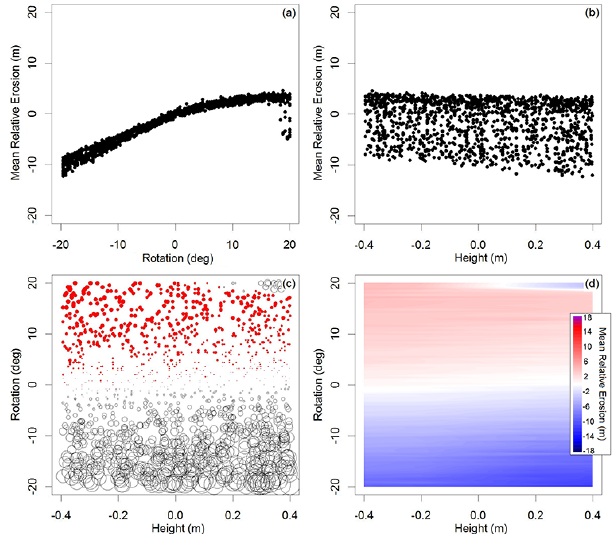
Figure 6. Wave rotation (a) and wave height (b) components of wave climate plotted against spatially averaged mean relative ero- sion over the 90-year period. Negative erosion values indicate a rel- ative reduction in the erosion rate in comparison to the baseline. Wave height and rotation perturbation factors are plotted together (c) . The size of each symbol is relative to the change in mean ero- sion rate imparted by that wave climate in comparison to the base- line scenario. Red dots represent increased erosion relative to the baseline and empty circles reduced erosion. The same data have been a contoured (d) . The scale on this plot represents spatially av- eraged (mean value for the coast as a whole) relative erosion (m) after 90 years of